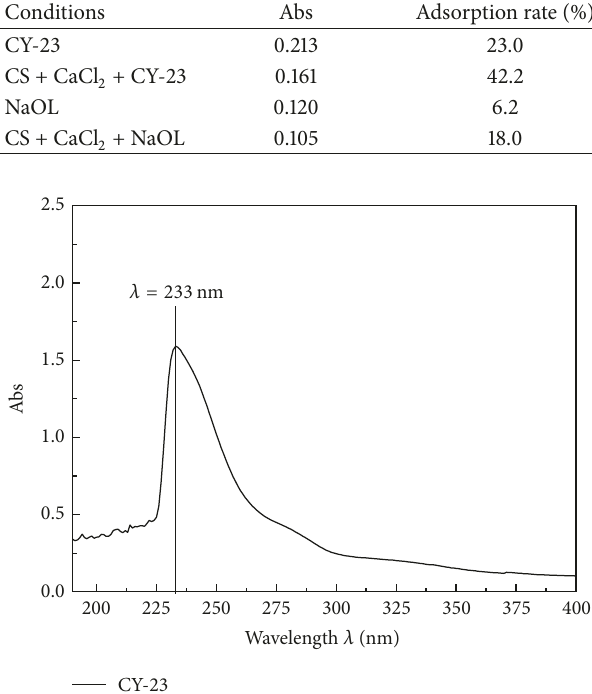
Figure 6: UV-Vis spectrum of CY-23 (test concentration 0.20%).